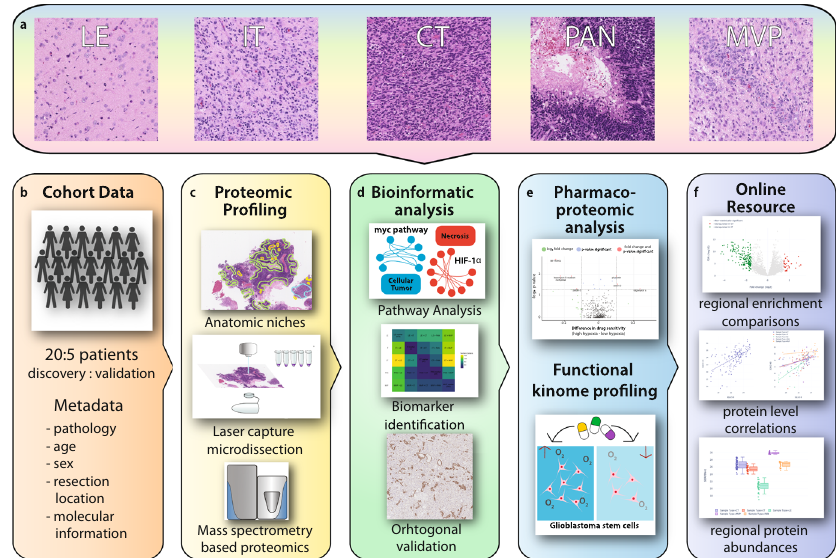
Fig. 1 Schematic overview detailing data generation, analysis and presentation. a Hematoxylin and Eosin (H&E) images detailing the anatomical niches within GBM: leading edge (LE), in fi ltrating tumor (IT), cellular tumor (CT), palisading cells around necrosis (PAN), and microvascular proliferations (MVP). b Collection of clinical data for a cohort of 20 GBMs. c FFPE tissue was sectioned and stained with H&E to identify histomorphological features. These were then excised using LCM and prepared for LC-MS/MS-based proteomics. d Bioinformatic pipeline including multi-dimensional scaling, differential expression matrix analysis, and gene set enrichment analysis (GSEA). e Selected region-speci fi c biomarkers were validated within an external cohort of patients by immunohistochemistry (IHC). Clinical signi fi cance of regions speci fi c markers was approximated using strati fi ed RNA levels from TCGA. f Data was deposited in an accessible online data portal to allow for interactive and real-time exploration and comparison of proteomic pro fi les within